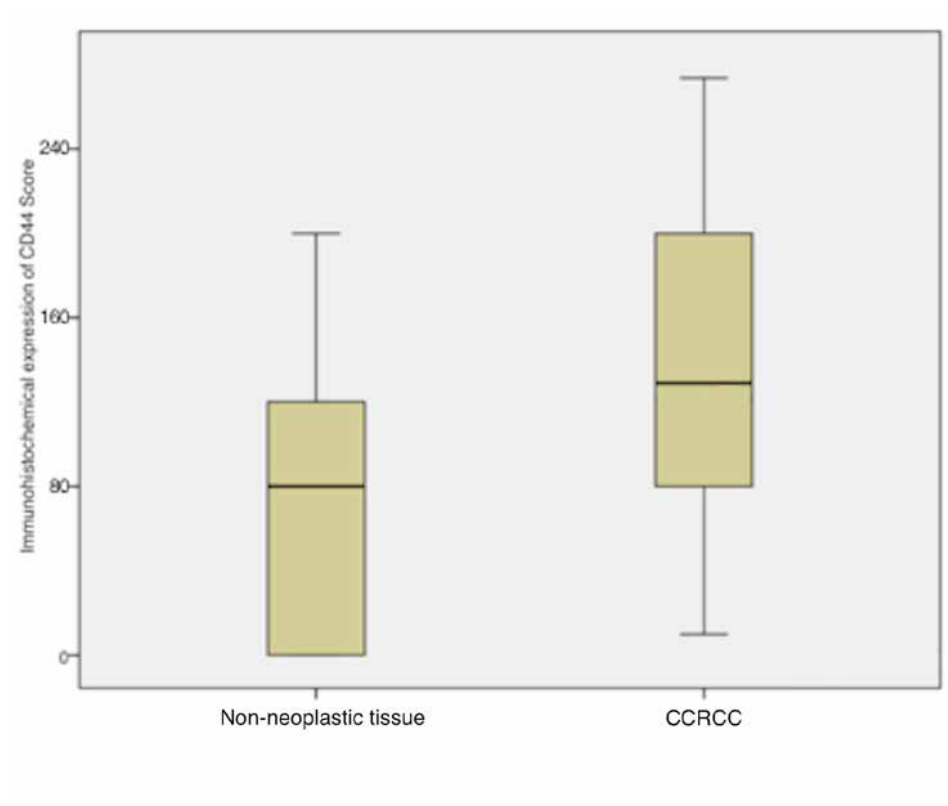
Figure 2 - Box plots for non-neoplastic tissue and ccRcc. Box represents values from lower to upper quartiles. central line represents